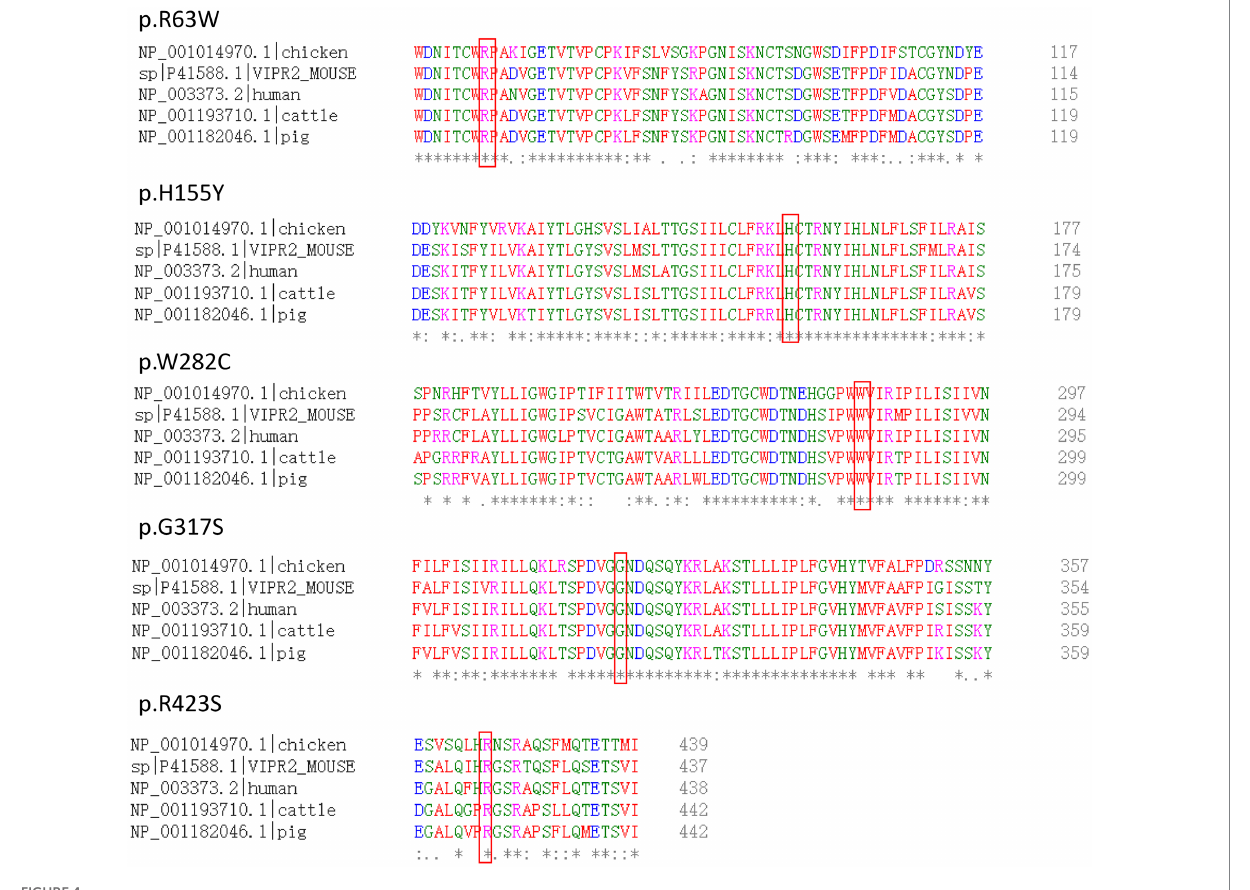
FIGURE 4 Multiple alignments of VPAC2 protein sequences of various species. The sites of non-synonymous variants were box out.